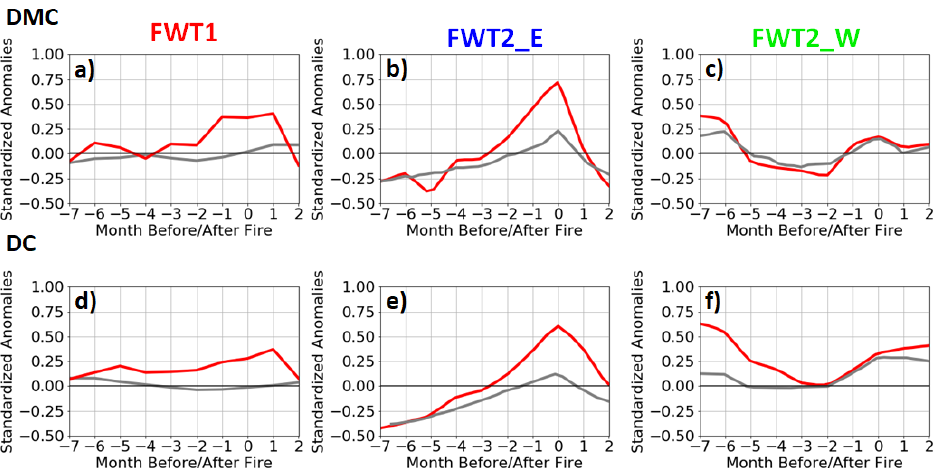
Figure 8. As in Figure 7, but for (a-c) Duff Moisture Code (DMC) and (d-f) Drought Code (DC) at 9 month timescales.